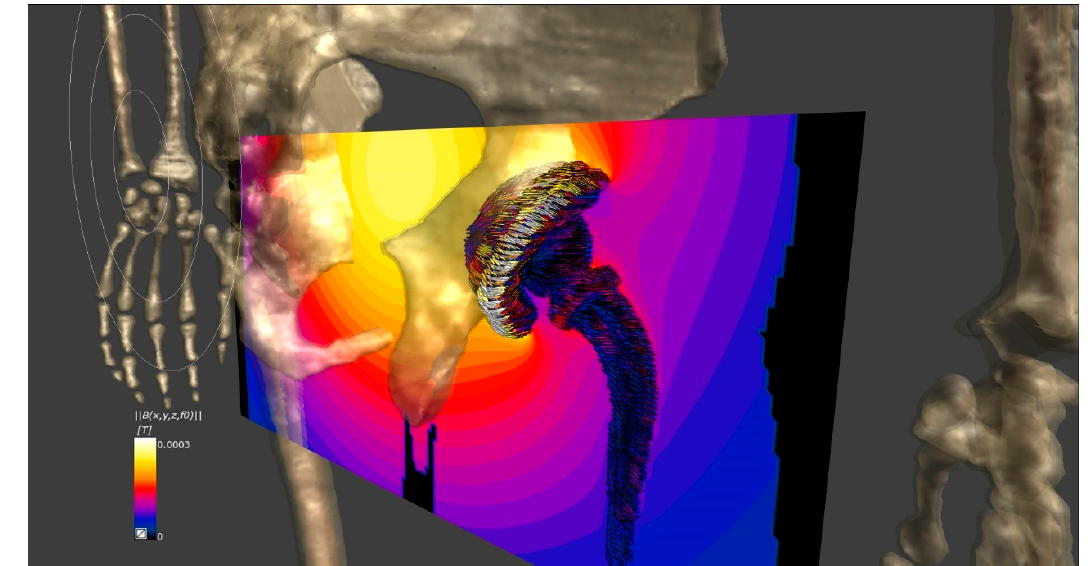
Figure 7. Calculated field and temperature patterns in and around the hip implant of a prospective patient of magnetic hyperthermia to treat a prostate tumor.